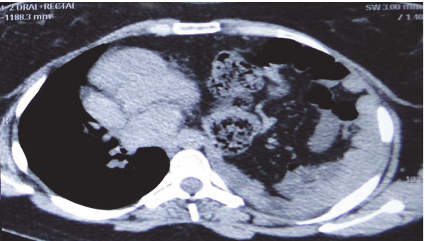
Figure 5: CT scan showing small intestine herniation in left Bochdalek